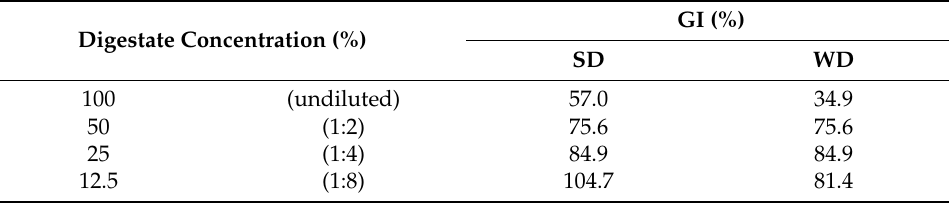
Table 1. Relative seed germination index (GI) of maize under different digestate concentrations, expressed as the percentage of germinated seeds relative to the control GI (distilled water).